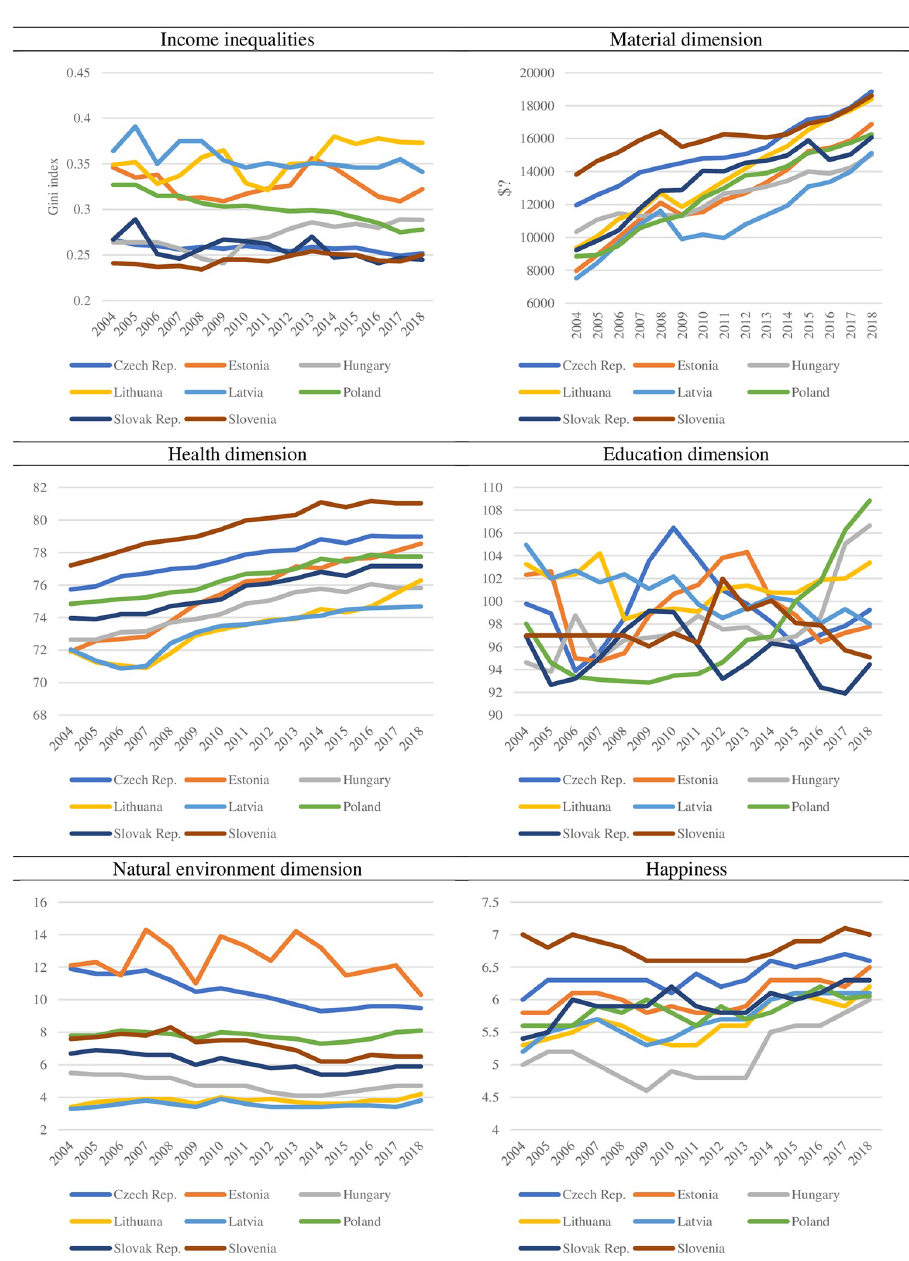
Fig 1. Income inequalities and five dimensions of well-being in selected CEE countries. Source: Own evaluation on the basis of OECD, Eurostat, World Bank, World Database of Happiness, International Energy Agency.